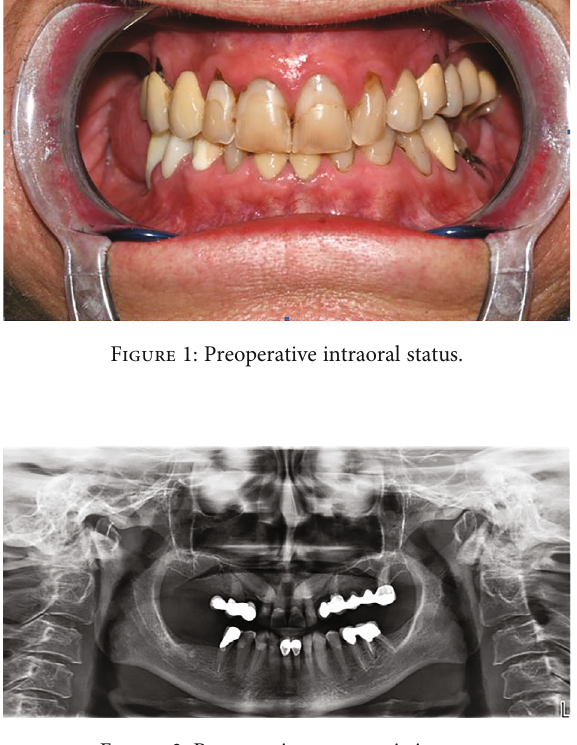
Figure 2: Preoperative panoramic